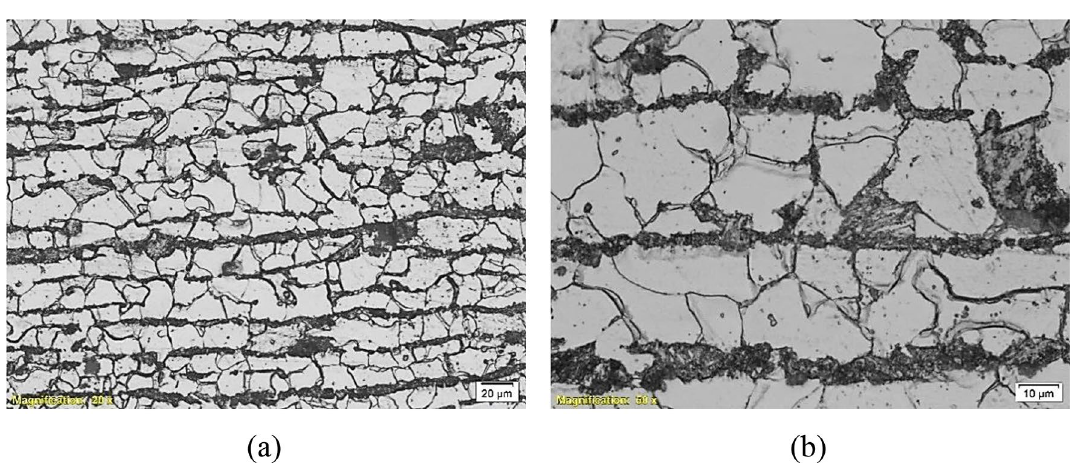
Figure 10. Microstructure of the failed elbow B21: ( a ) cross-section at external corroded surface and ( b ) higher magnification showing typical microstructure of carbon